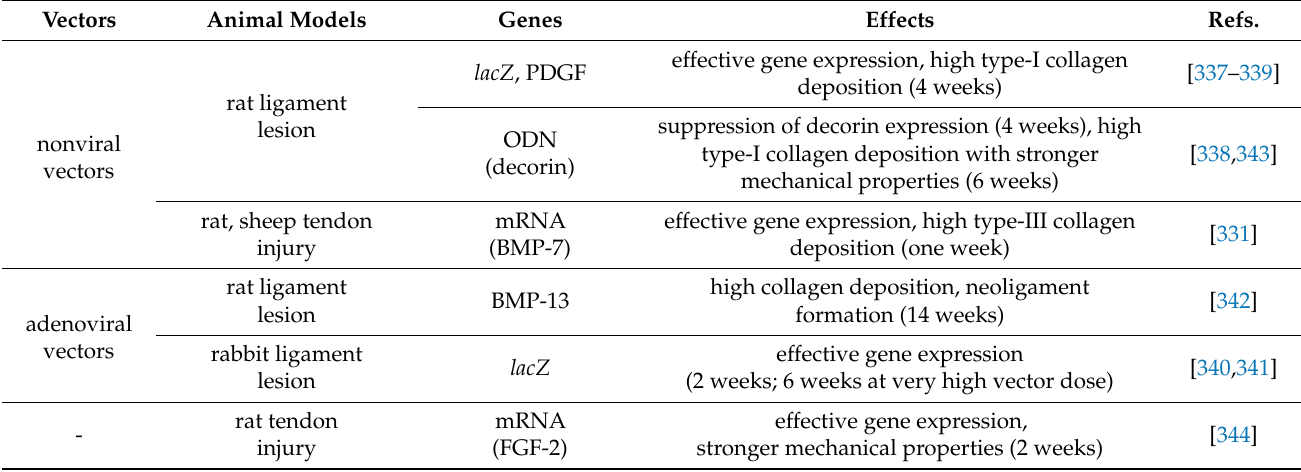
Table 4. Applications of classical gene therapy for direct ACL repair in